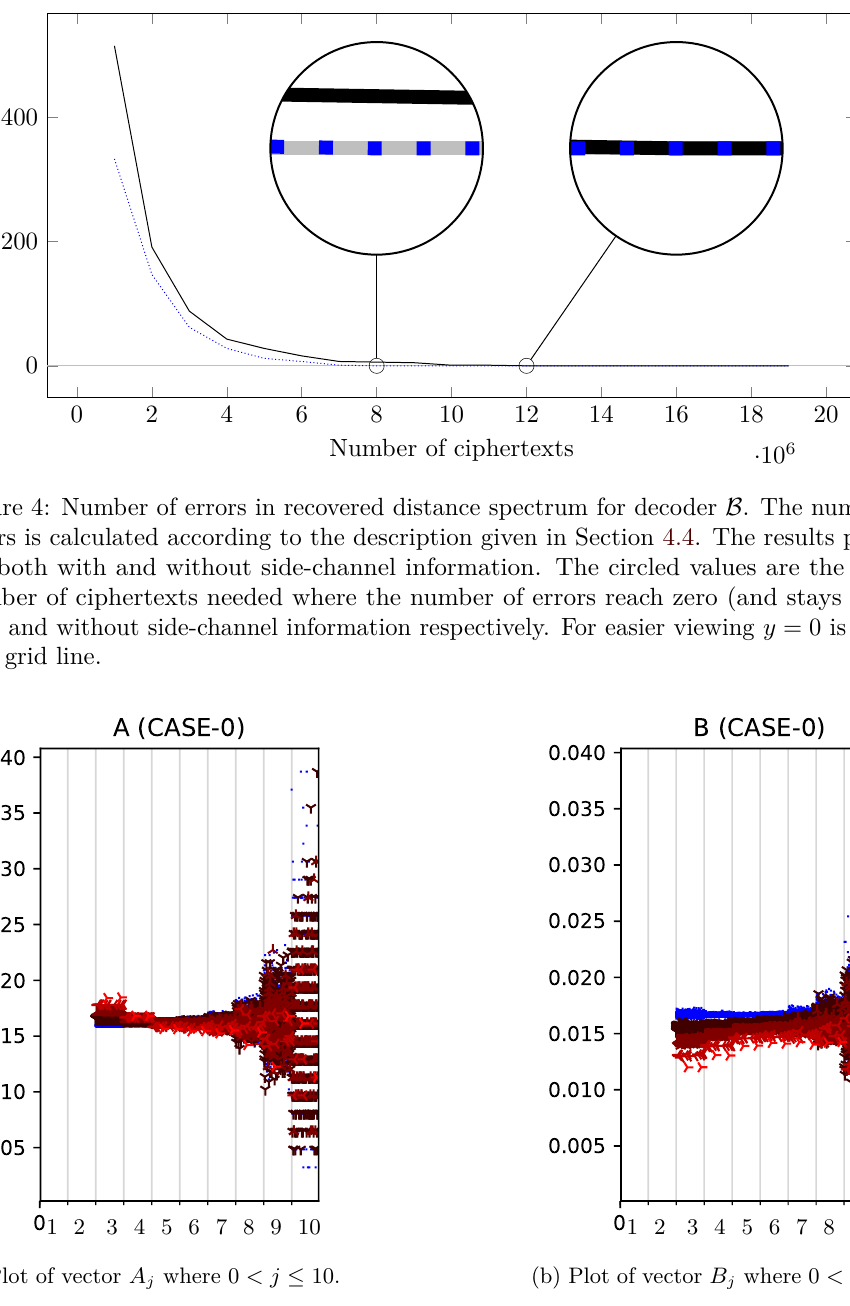
Figure 5: Decoder B : The plot for vectors A and B . The vectors have been converted to show probabilities instead of raw values, for easier understanding of y-values. This data is based on 2 28 ciphertexts. The plots show the probability for decoding success using j (x-axis) number of iterations for each distance in the distance spectrum. j in this plot is discrete and ranges from 1 to 10 and is indicated by the grid lines. The wider range of values for certain iterations (e.g. j = 10) are a by-product of the smaller sample size. In the Figure 5a we can see that I = 5 since the probabilities flip for the results where j ≥